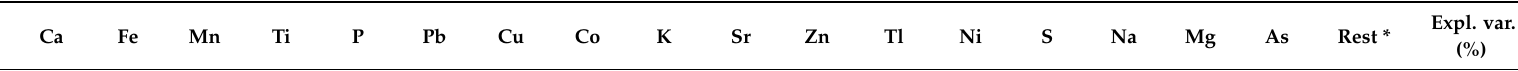
Table 4. Singular correlation coefficient matrix and Factor Analysis (FA) data of Mn-Fe oxyhydroxides from the C-NSC (based on EPMA). Bolded correlations